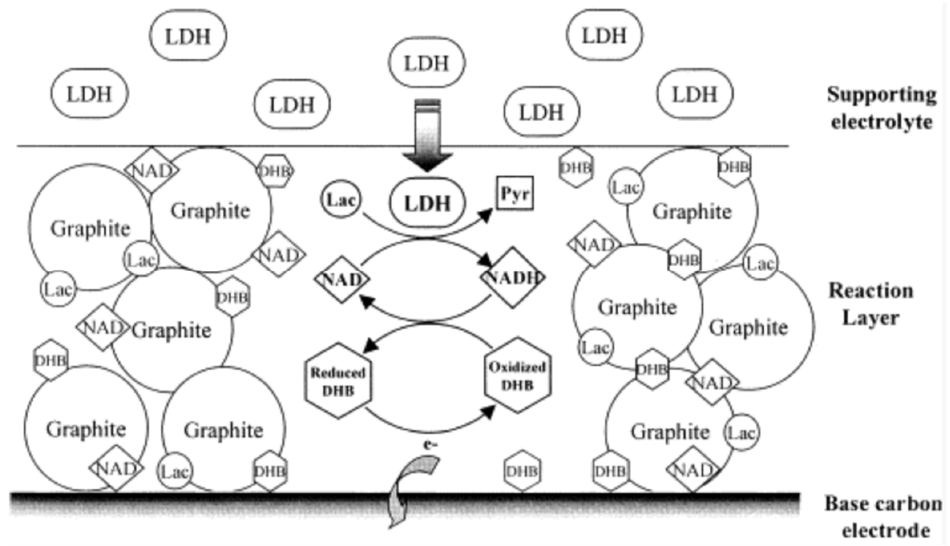
Figure 4. Response scheme for thick film LDH biosensors [106] . Copyright 2002 Elsevier.